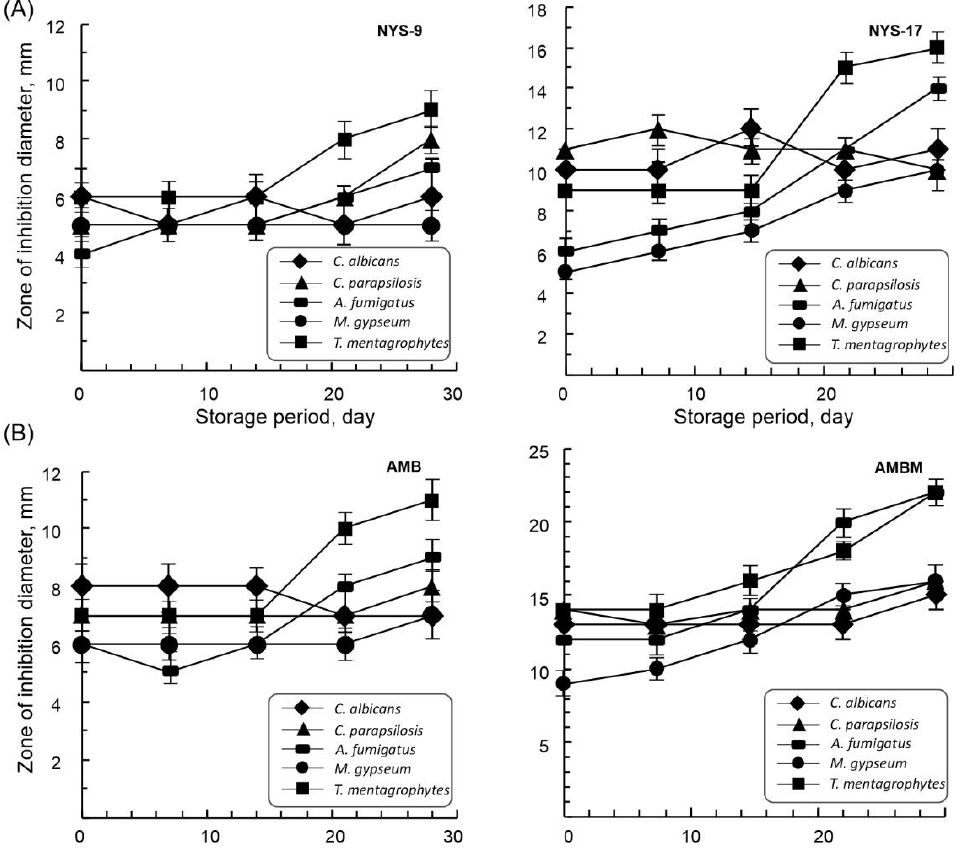
Figure 3. Zones of inhibition and stability of mcl-PHA films containing polyenes; ( A ) NYS (NYS-9, NYS-17 with 0.2% and 2% wt of nystatin, respectively), and ( B ) AMB (AMB and AMB-M with 0.1% and 1% wt of amphotericin B and 0.4% wt C10-OH monomer, respectively).